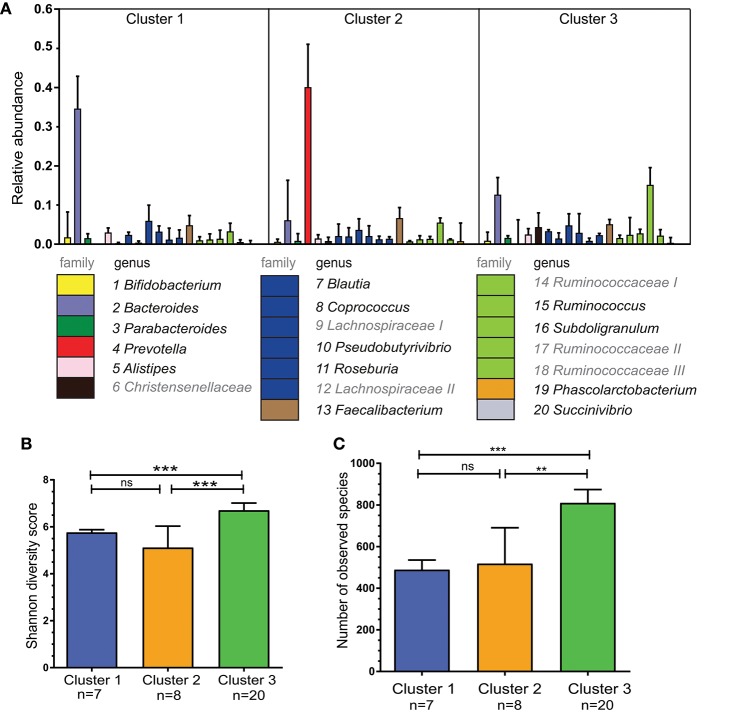
Bacterial diversity differs between the three specified clusters. (A) Relative abundance per cluster of the 20 most abundant bacteria present in our cohort. Each column shows the median plus interquartile range of the relative abundance of bacterial genera (or if not identified bacterial family), relative abundance of 1.0 = 100%. The numbers below indicate corresponding genus, colors show the bacterial family of the various genera. Ruminococcaceae I, II, and III and Lachnospiraceae I and II could not be assigned to different genera, but differ in OTU clusters. (B) Shannon diversity index for each of the three clusters to determine bacterial diversity. (C) Bacterial richness - defined as the total number of observed unique species per cluster. Bars represent median values with interqartile range. Statistics were calculated with Mann-Whitney U test. **P < 0.01; ***P < 0.001.